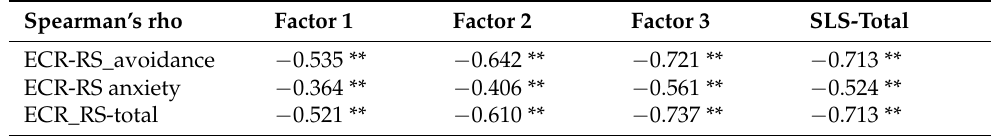
Table 6. Correlations between SLS-12 subscales and ECR-RS subscales (N = 941). Spearman’s rho Factor 1 Factor 2 Factor 3